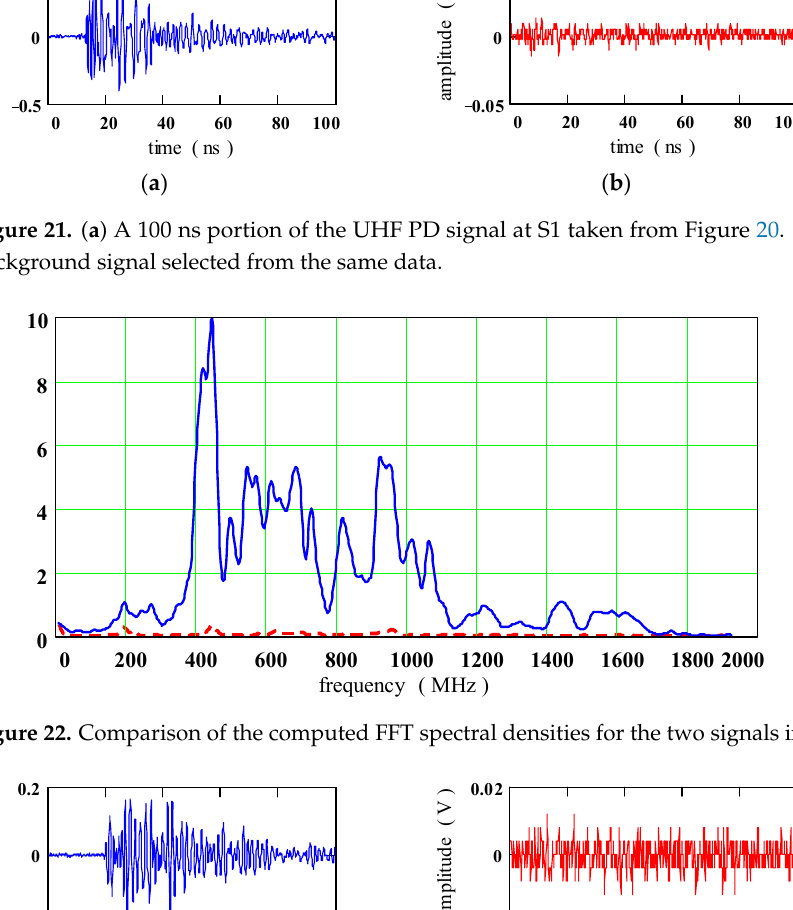
Figure 21. ( a ) A 100 ns portion of the UHF PD signal at S1 taken from Figure 20. ( b ) A portion of background signal selected from the same data.